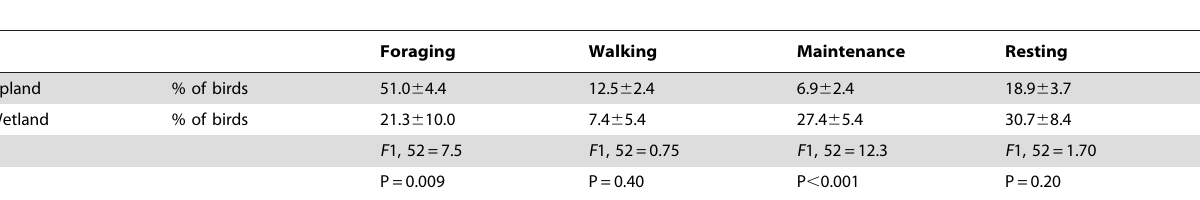
Table 2. Behavior of Buff-breasted Sandpipers in dry upland sites differed from behavior at wetlands.